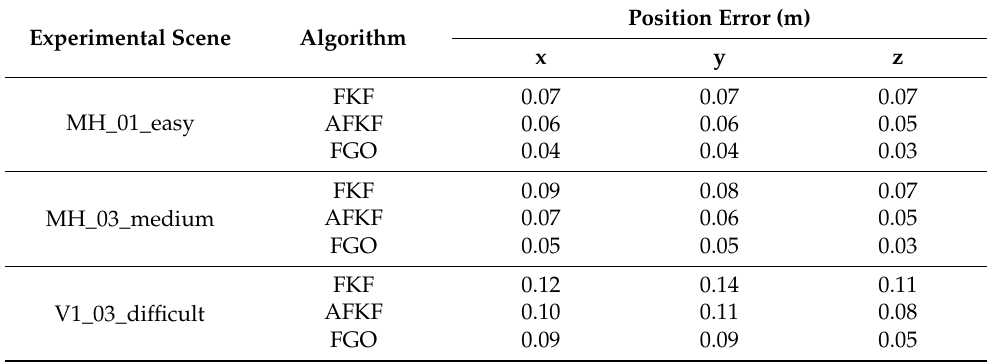
Table 8. Accuracy comparison results of different algorithms in different scenarios. Experimental